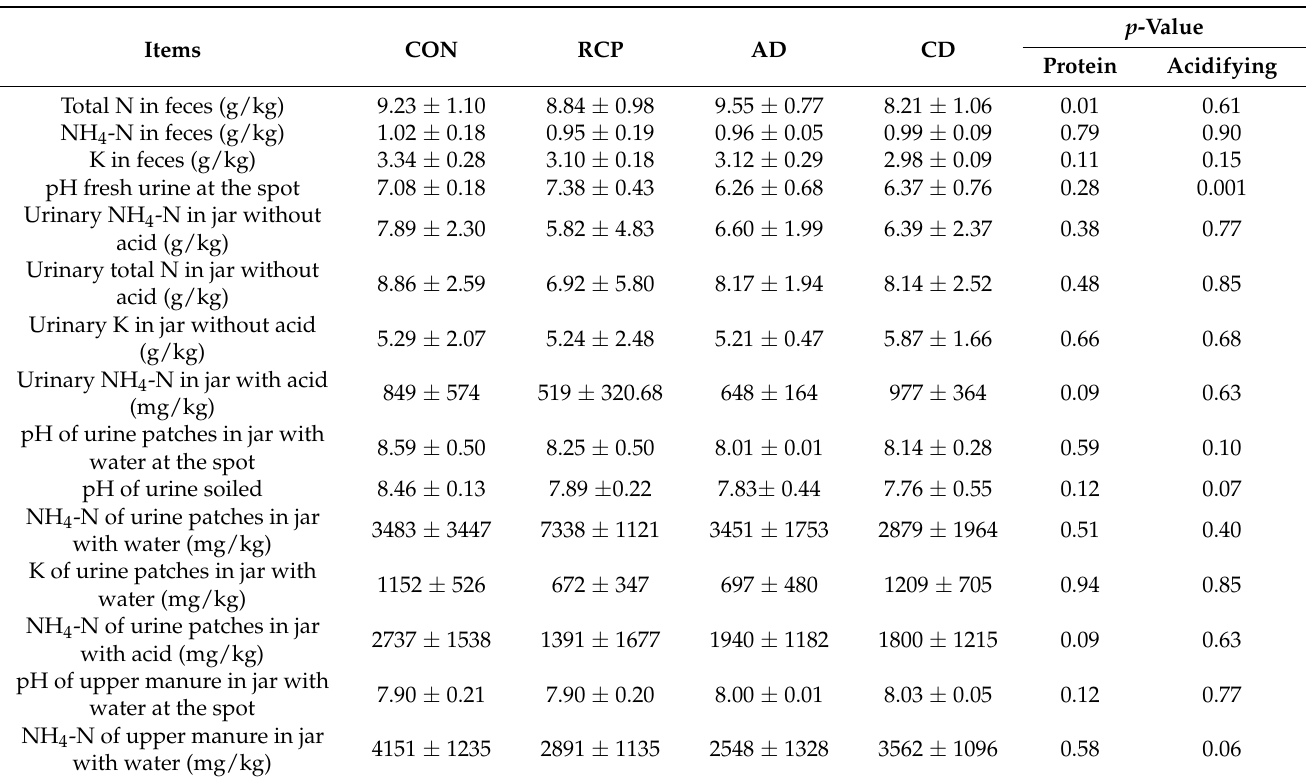
Table 5. Effects of experimental diets on urine and feces characteristics (mean ± standard deviation, n =